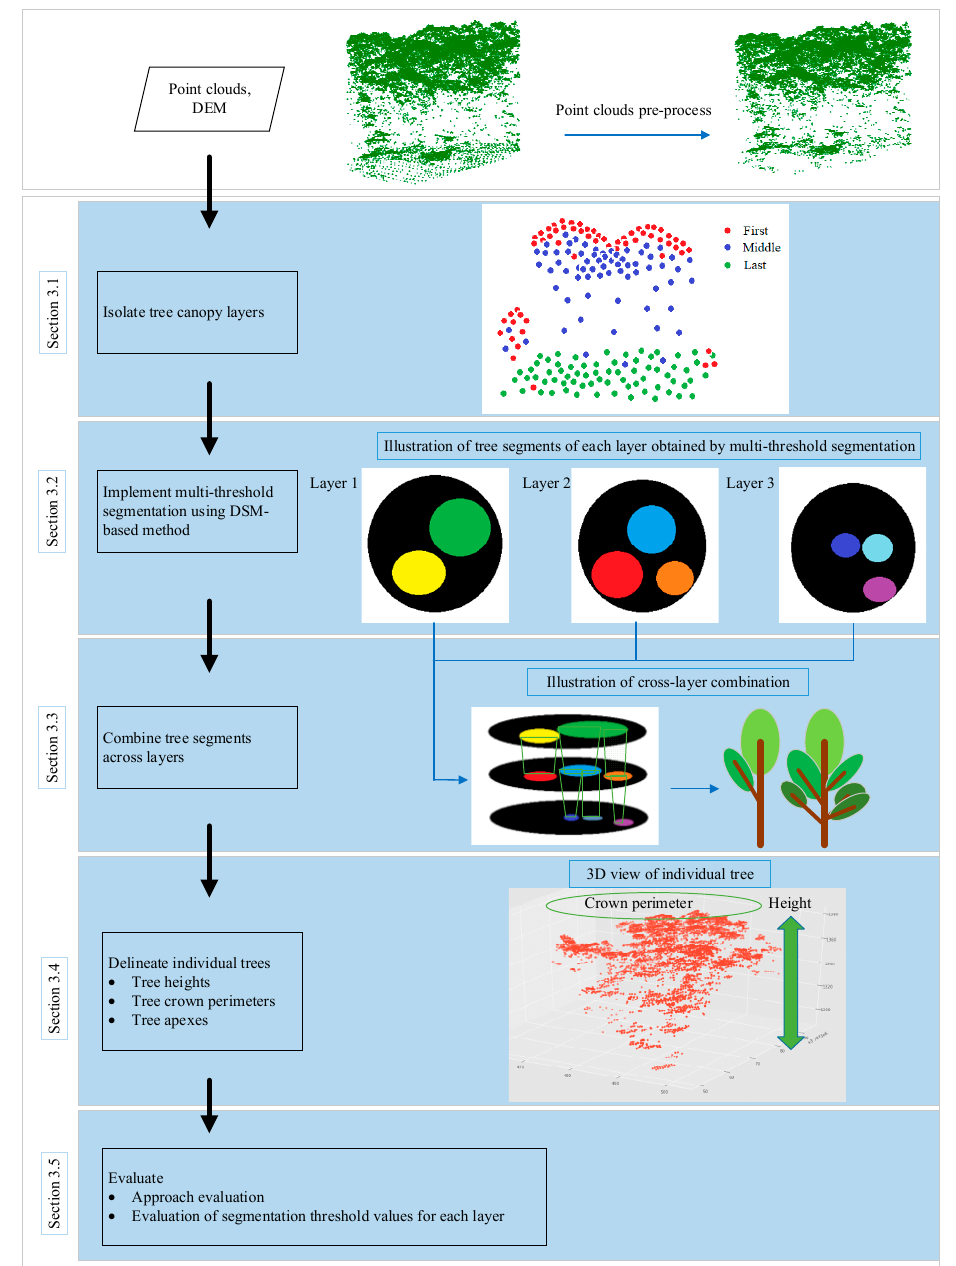
Figure 1. Flowchart of the multi-threshold segmentation method.